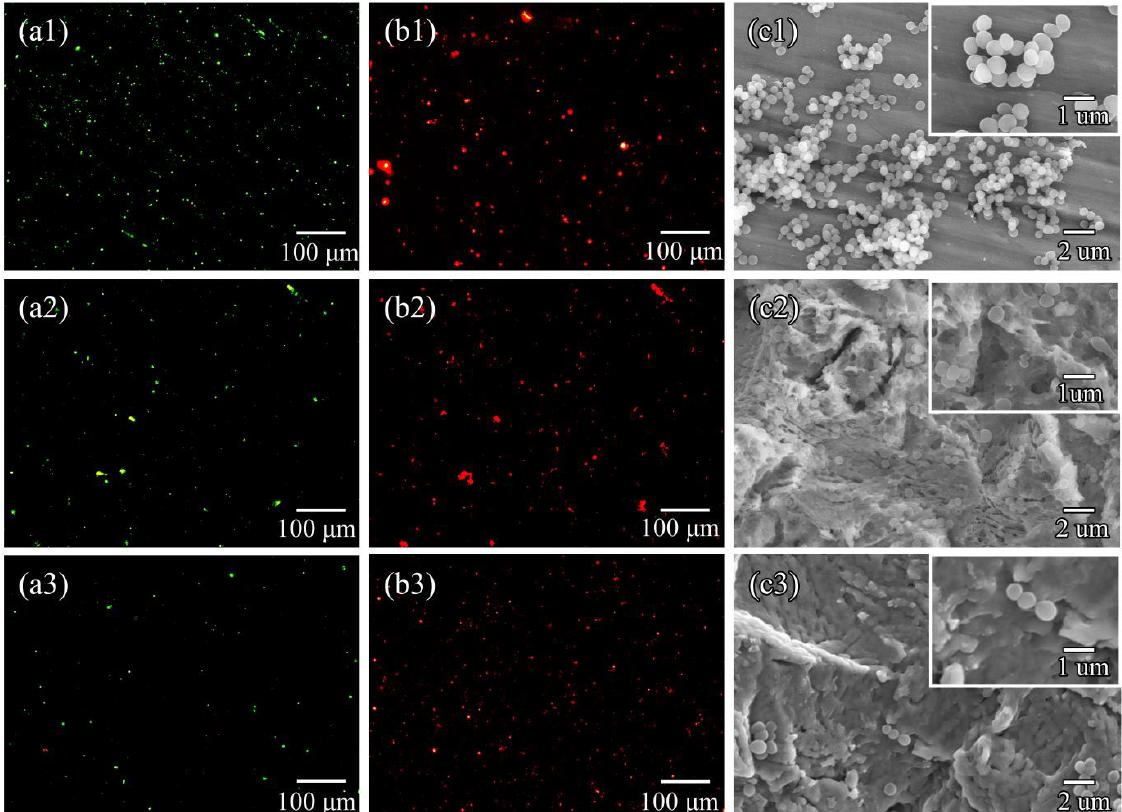
Figure 6. Live/dead staining and SEM morphology of S. aureus after 24 h incubation. ( a1 ) Live bacteria on the surface of cp-Ti samples; ( b1 ) Dead bacteria on the surface of cp-Ti samples; ( c1 ) The SEM morphology of cp-Ti samples; ( a2 ) Live bacteria on the surface of Ti-Cu-S samples; ( b2 ) Dead bacteria on the surface of Ti-Cu-S samples; ( c2 ) The SEM morphology of Ti-Cu-S samples; ( a3 ) Live bacteria on the surface of Ti-Cu-SA samples; ( b3 ) Dead bacteria on the surface of Ti-Cu-SA samples; ( c3 ) The SEM morphology of Ti-Cu-SA samples.